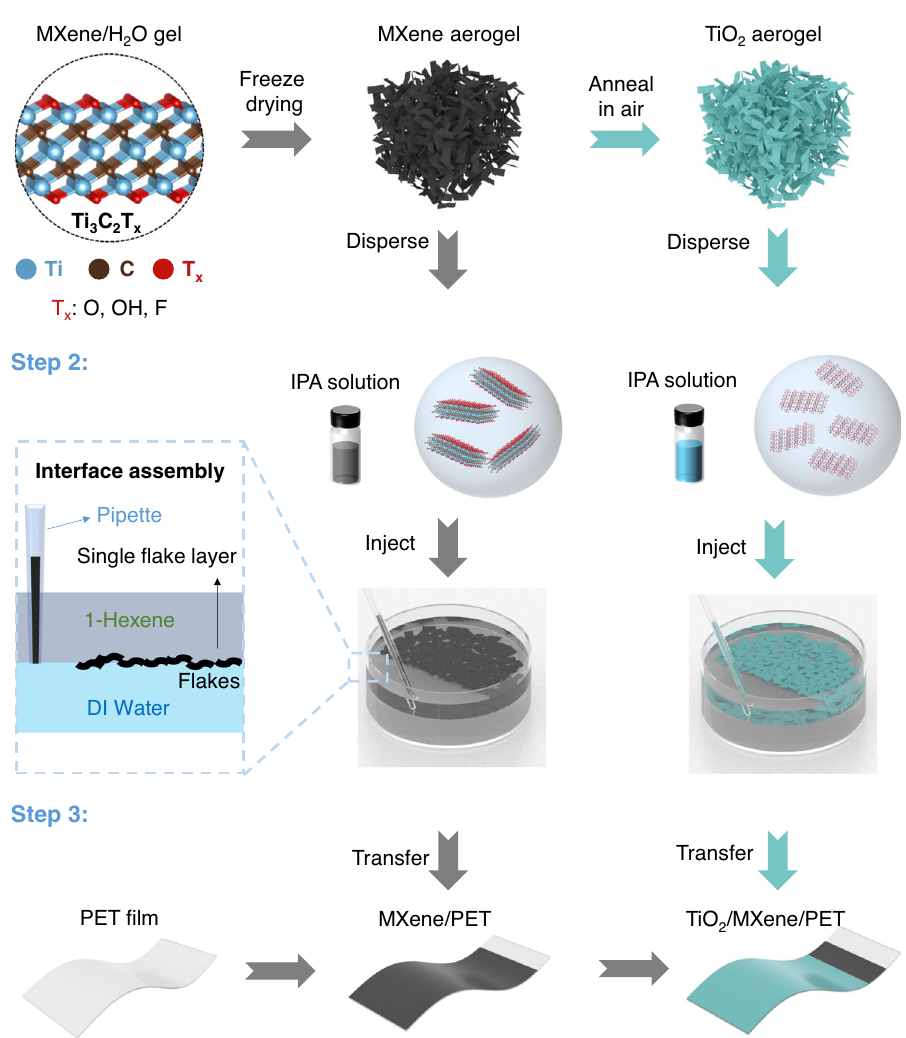
Fig. 1 Fabrication process of TiO 2 /Ti 3 C 2 T x heterostructure on a fl exible substrate. Step 1: MXene (Ti 3 C 2 T x , crystal structures in the left panel, is drawn by Vesta software) aerogel is obtained by freeze drying of the Ti 3 C 2 T x nanosheets dispersion and the derived TiO 2 aerogel is obtained by annealing the MXene aerogel in air at 400 °C. Step 2: Ti 3 C 2 T x and TiO 2 2D nanosheets are dispersed, respectively, in IPA, injected into the interface between hexene and DI water, and self-assembled into nanometer-thick Ti 3 C 2 T x and TiO 2 fi lms. Step 3: the thin fi lms are transferred onto a fl exible substrate (e.g., PET) in a layer-by-layer fashion to realize the TiO 2 /MXene heterostructure, where the TiO 2 layer serves as the electrochromic component, and the MXene layer serves as the transparent